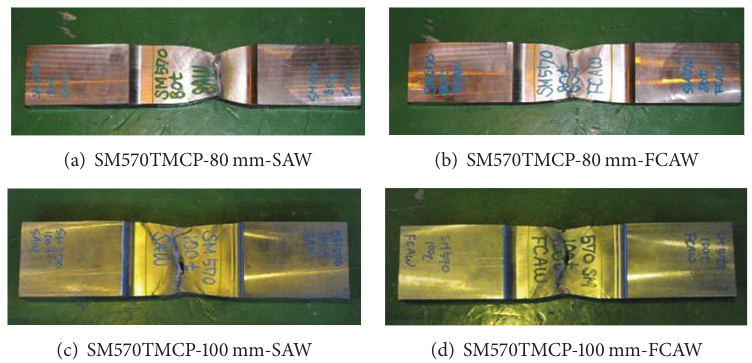
Figure 5: Tensile test result of SAW and FCAW for SM570TMCP 80mm and 100mm.